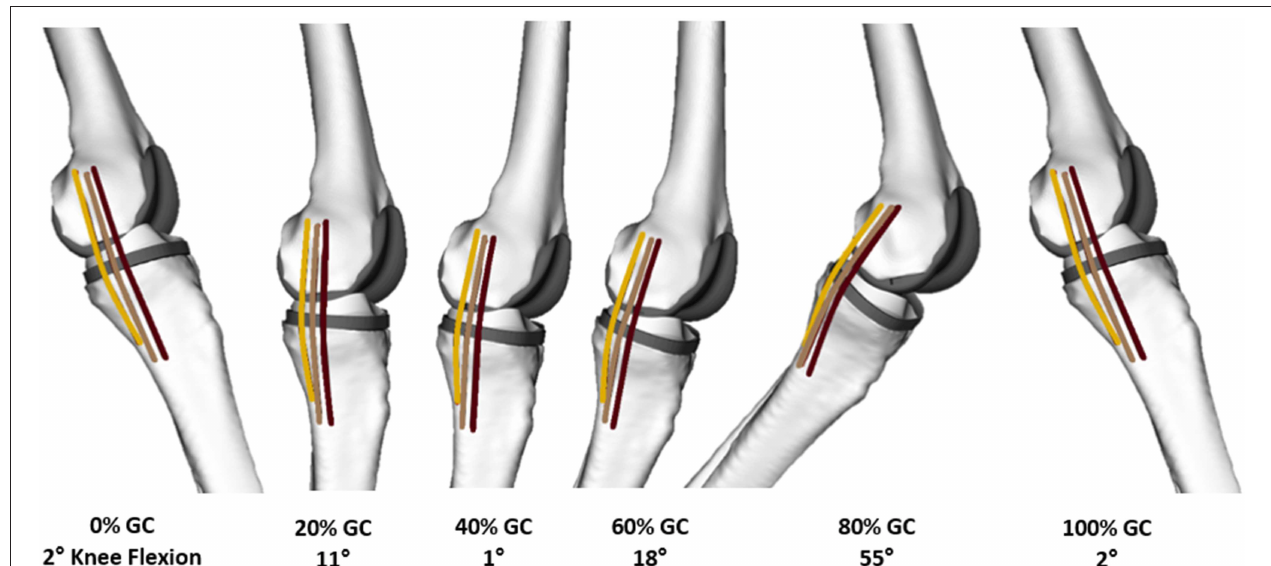
FIGURE 3 | A medial view of the knee of a representative subject with the GMK Sphere implant at different instances throughout a level walking gait cycle (GC). Linear elements represent each of the anterior (dark brown), intermediate (light brown), and posterior (amber) bundles of the MCL.